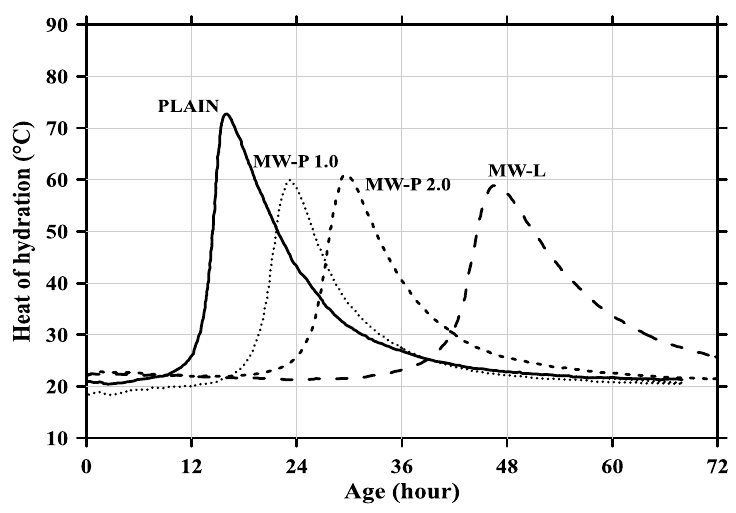
Figure 5. Heat of hydration.